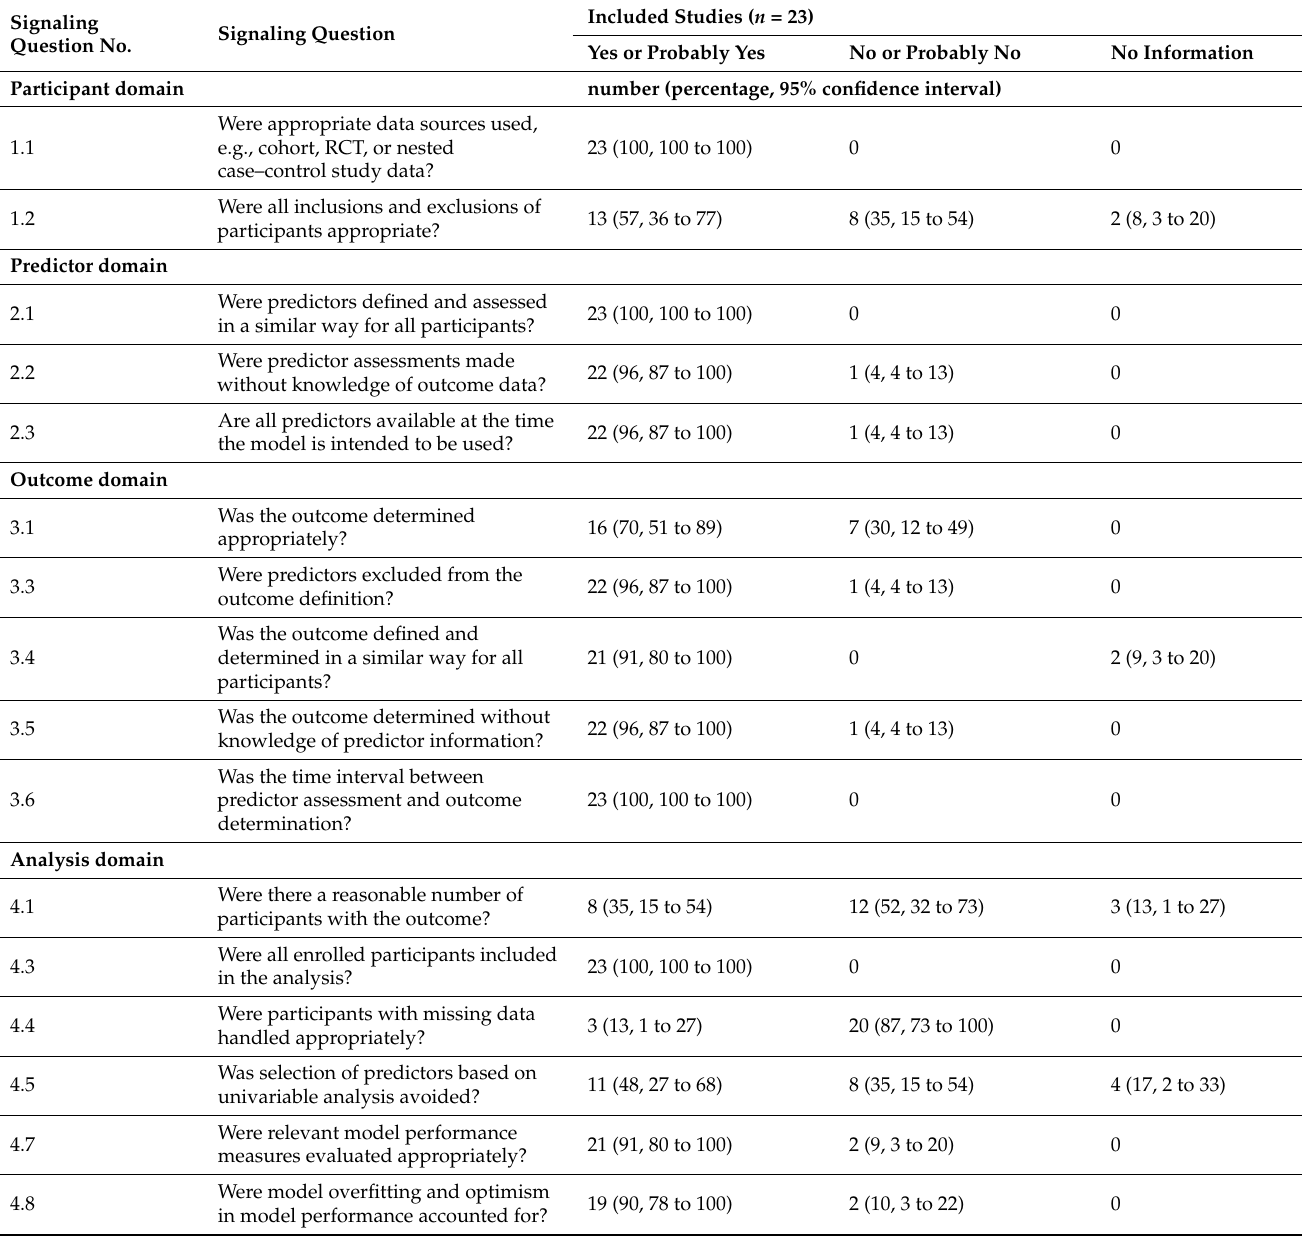
Table 3. PROBAST signaling questions in 23 included